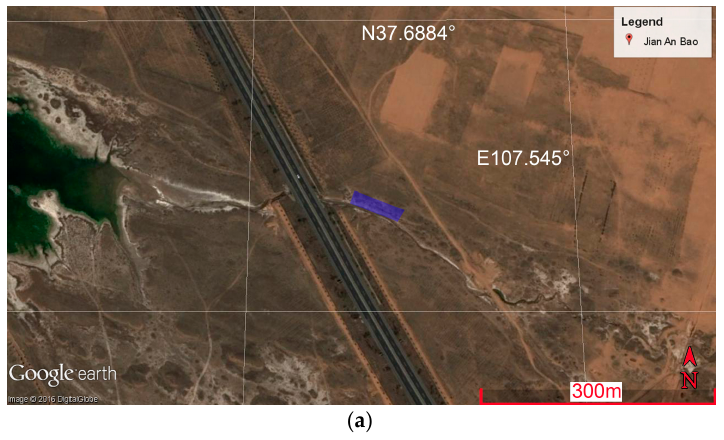
Figure 6. Maps of the study areas ( a ) Zhenbei Tai (31 January 2016, photos from Google Earth), the scanned area is in light blue and is about 3180 m 2 ; ( b ) Jianan Bao (21 March 2014, photos from Google Earth), the scanned area is in light blue and is about 5330 m 2 .